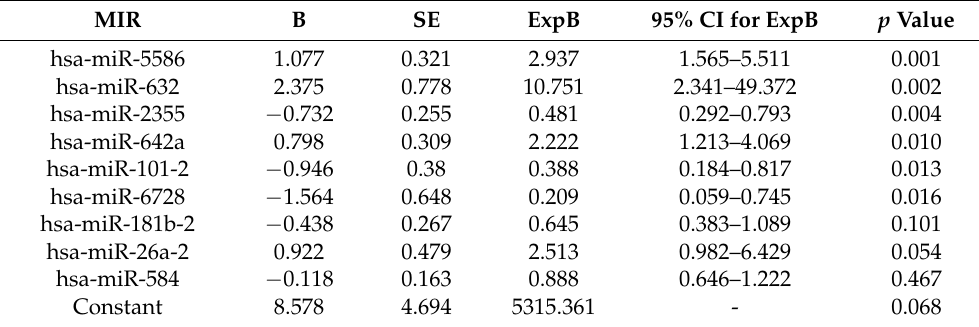
Figure 3. ROC curve of cross-validated logistic regression model of the chemotherapy-response signature in HNSC and CESC samples ( A ). Variable importance determined by logistic regression, miRNAs with significant result listed ( B ). Boxplots of the expression of significant genes in HNSC and CESC samples ( C – H ). Table 5. miRNAs significant in a logistic regression model combining CESC and HNSC samples.